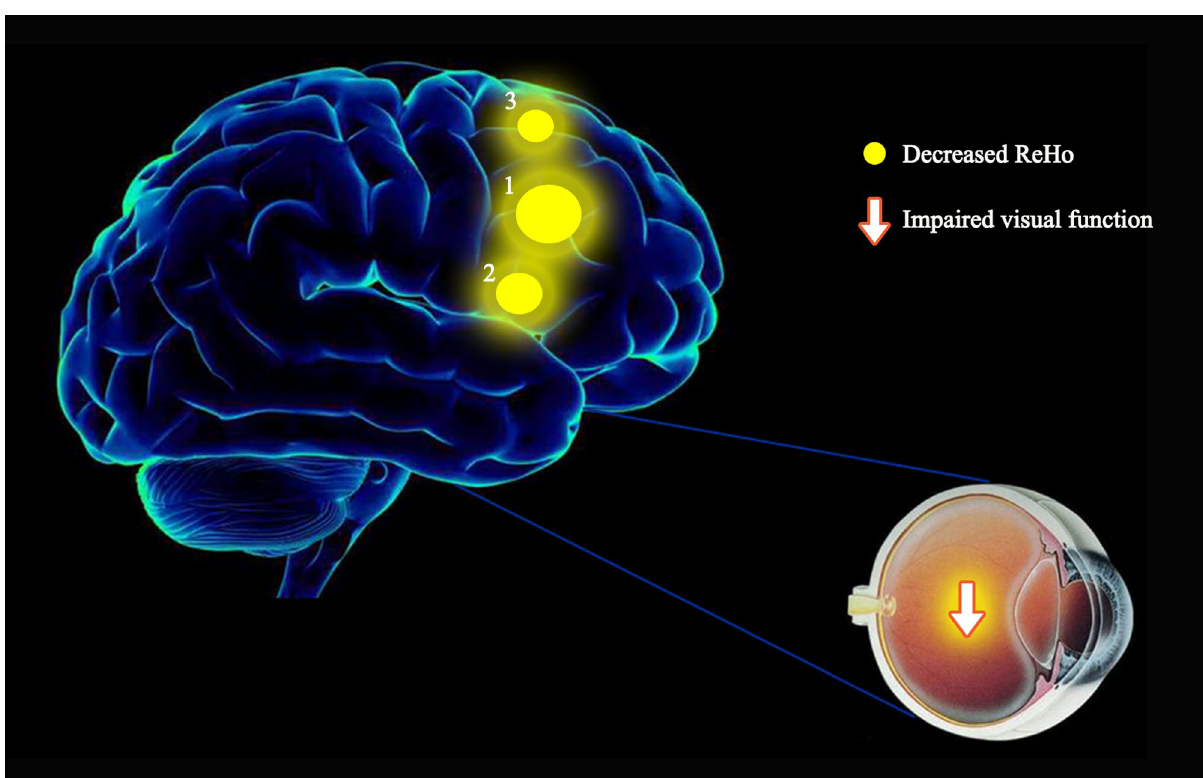
Figure 5. The mean ReHo values of altered brain regions. Compared with the HCs, the ReHo values of the following regions were decreased to various extents: (1) Middle frontal gyrus (t = 5.0282), (2) Inferior frontal gyrus triangular part (t = 4.7284), (3) Superior frontal gyrus dorsolateral (t = 4.4802). HCs healthy controls, BA Brodmann’s